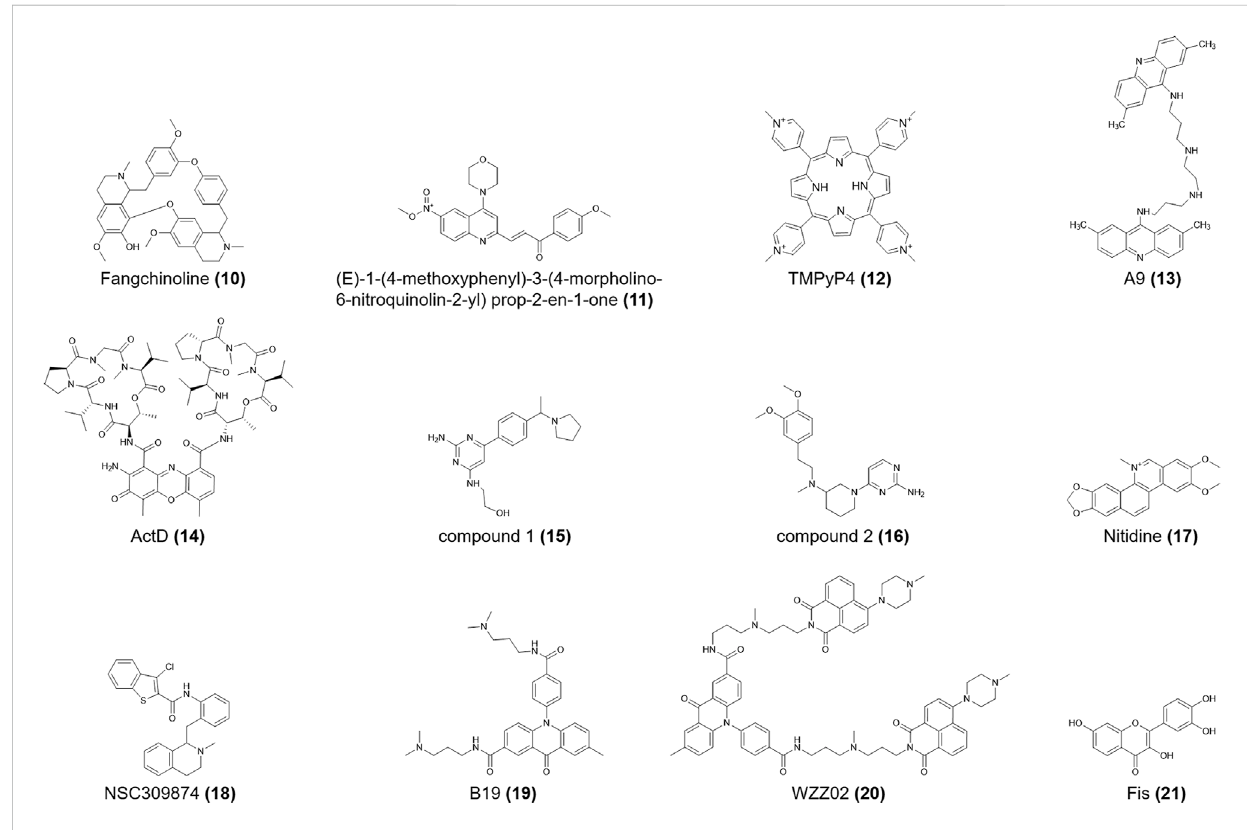
FIGURE 3 Structures of compounds ( 10 – 21